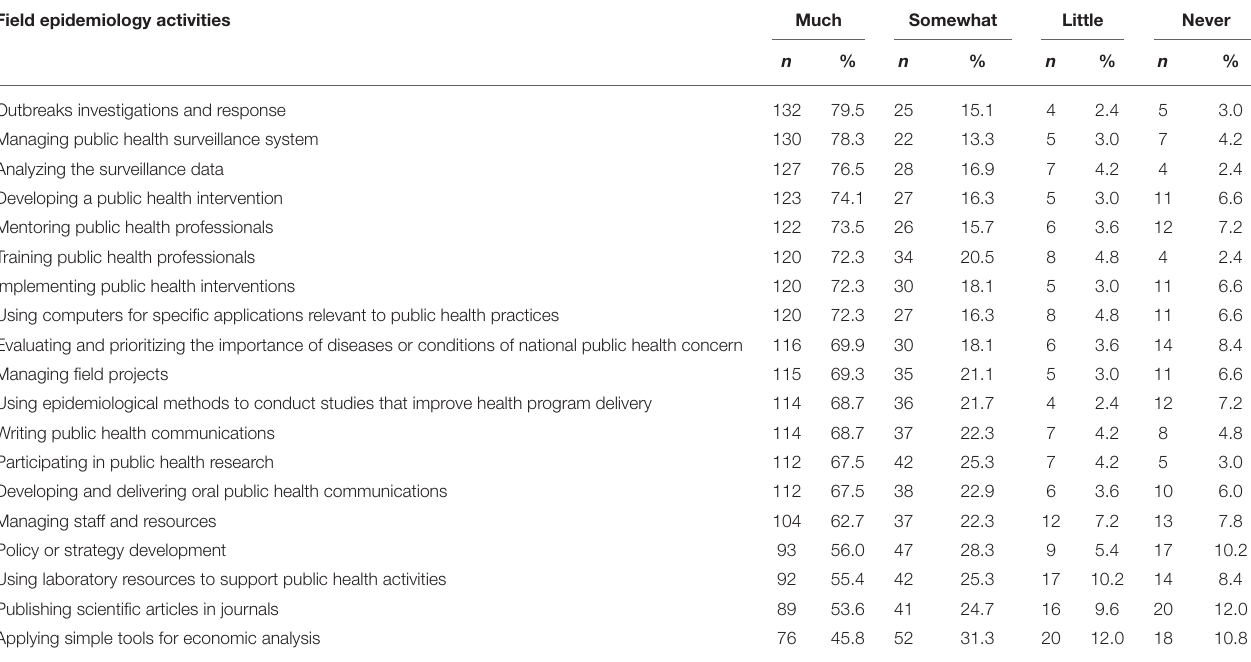
TABLE 3 | The extent to which FETP helped the graduates to perform field epidemiology activities.